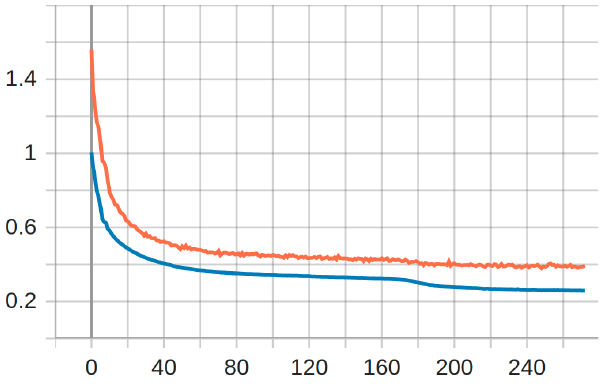
Figure 8. Loss over epochs. Orange color indicates training and blue indicates validation.